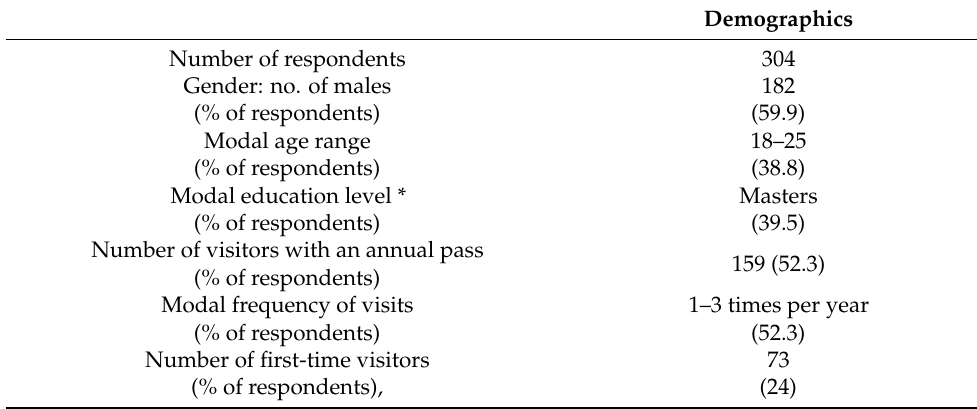
Table 2. Demographics of zoo visitors completing the survey. * These data were only collected for Jungle Kingdom